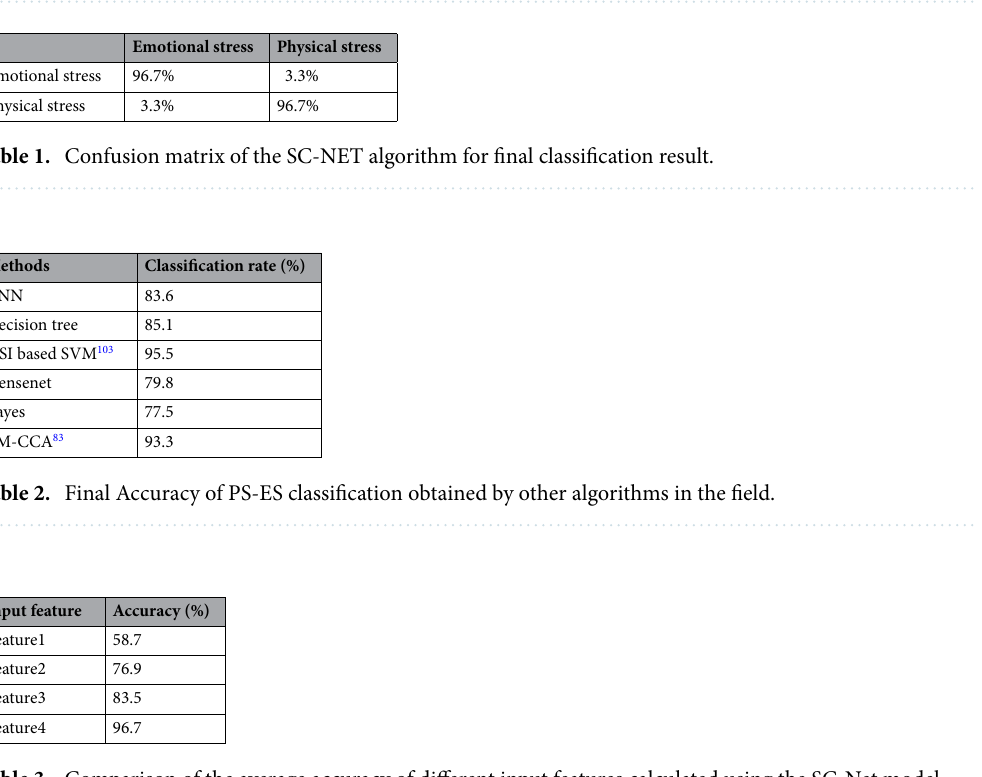
Table 3. Comparison of the average accuracy of different input features calculated using the SC-Net